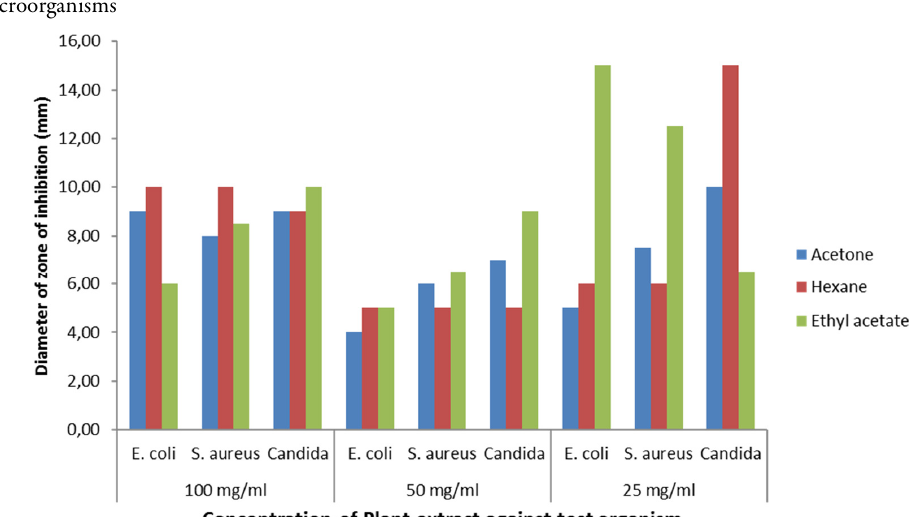
Figure 3. Average zones of inhibition of different concentrations of C. papaya leaves against the tested